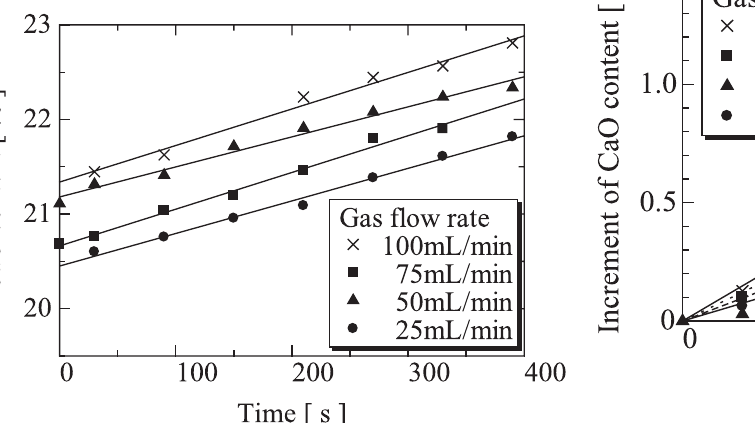
Fig. 7: Increment of CaO content with time when 3.5 g of slag (wt%) 2